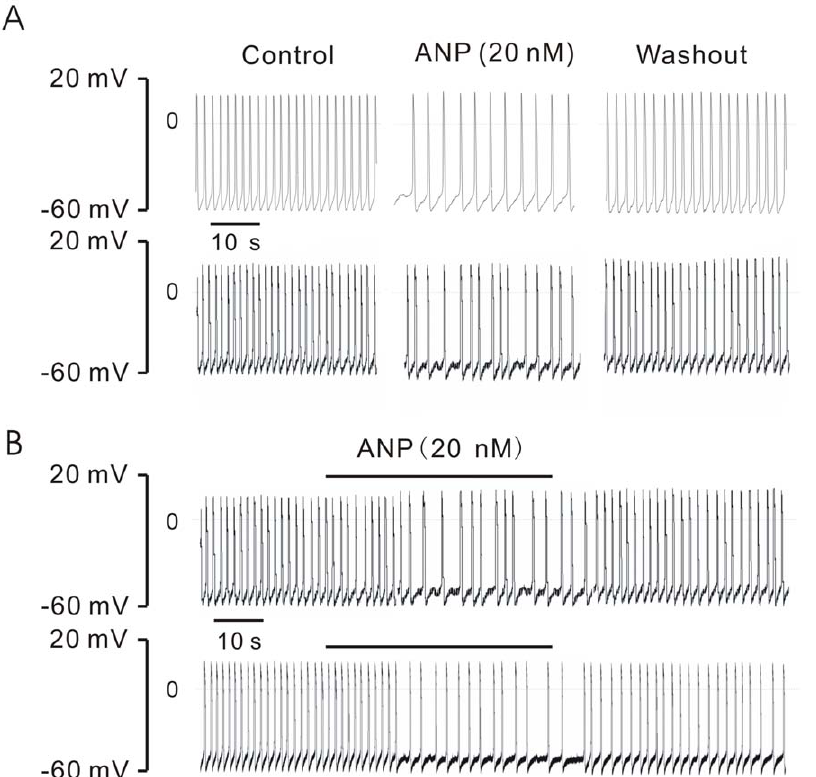
Figure 2. Inhibition of spontaneous action potentials by ANP. A : Action potentials recorded from a spontaneously contracting EDS cell (upper) and an E8.5d cardiomyocyte (lower) in the current clamp mode. The frequency of action potentials was decreased by application of ANP in a reversible manner. B : action potentials recorded from an early developmental stage EB (upper) and an embryonic 8.5 day heart (lower). As seen in single EDS and E8.5d cells, application of ANP exerted a negative chronotropic effect that was washable.